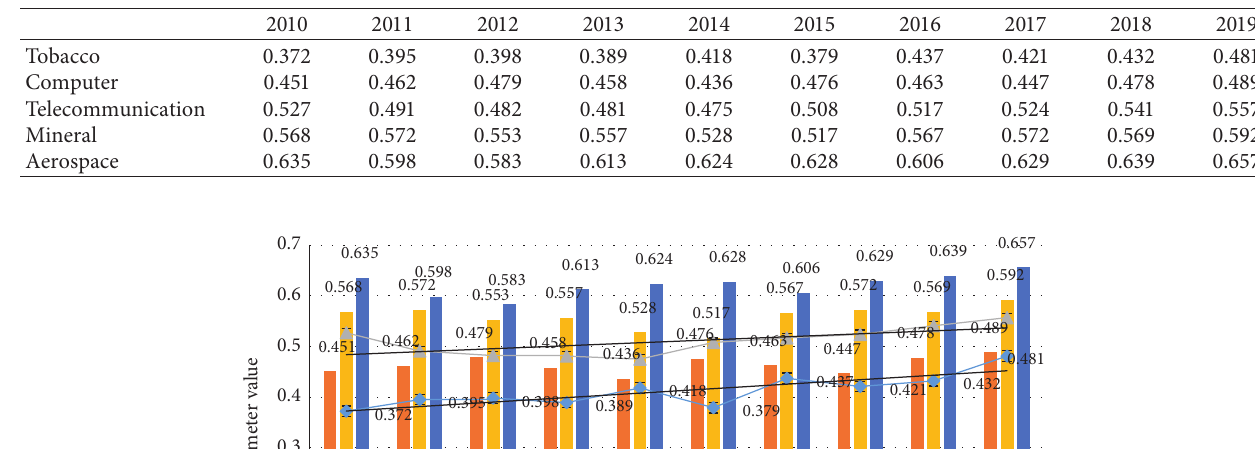
Figure 5: Refined results. Table 4: Green innovation in various industries.